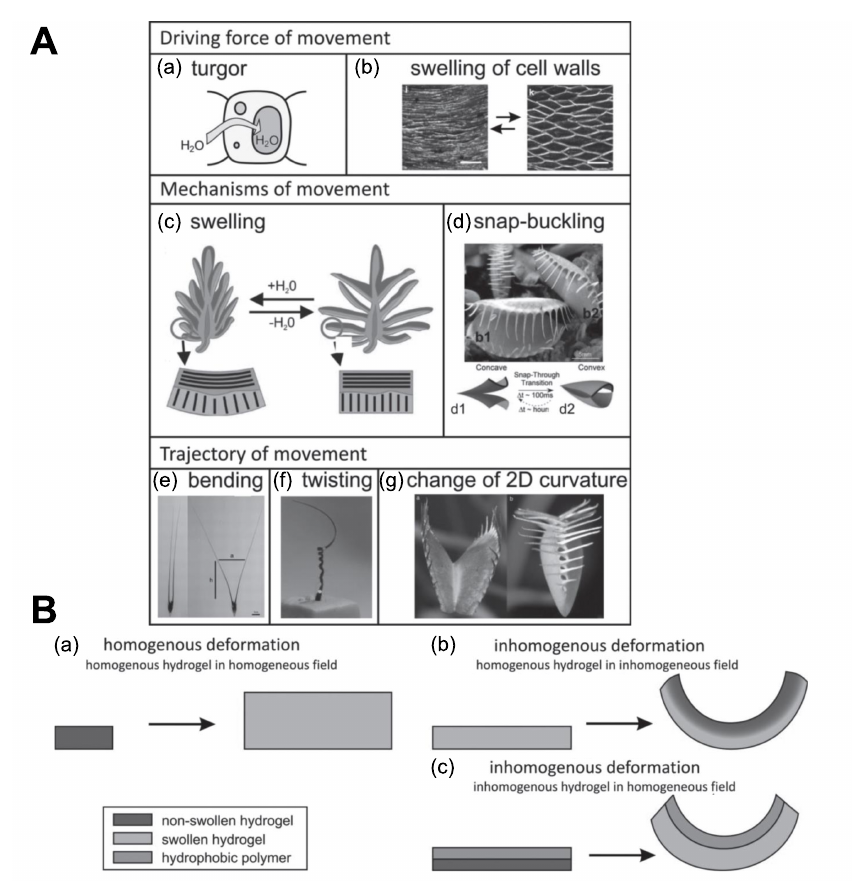
Figure 6. ( A ) Examples of reversible movement in plants with respect to the driving force: ( a ) turgor, and ( b ) swelling of cell walls; mechanism: ( c ) swelling, and ( d ) snap-buckling; and trajectory: ( e ) bending, ( f ) twisting, and ( g ) change of two-dimensional (2D) curvature. ( B ) Different scenarios of swelling of hydrogels: ( a ) homogeneous deformation of homogeneous hydrogel; ( b ) inhomogeneous deformation of homogeneous hydrogel; ( c ) inhomogeneous deformation of inhomogeneous hydrogel. ( A , B ) Adapted with permission from [8]. Copyright 2013, John Wiley & Sons